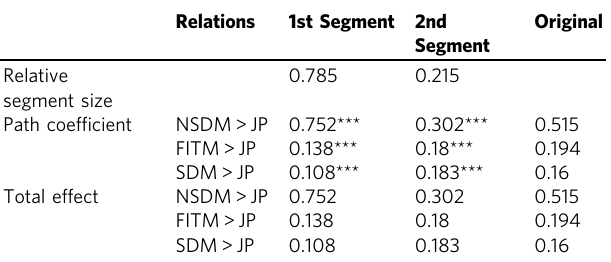
Table 7 Uncovering unobserved heterogeneity using FIMIX-